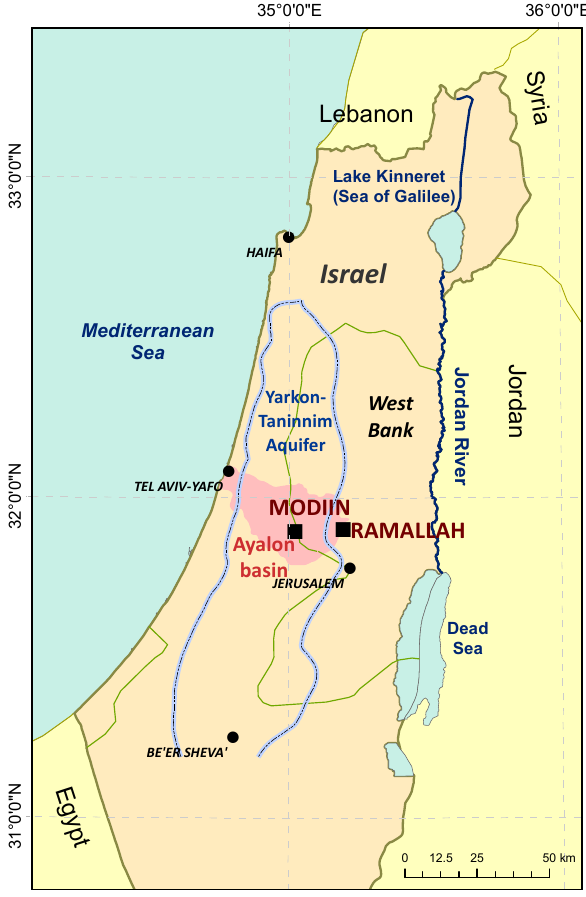
Fig. 1. Location map: the towns of Ramallah and Modiin within the Ayalon